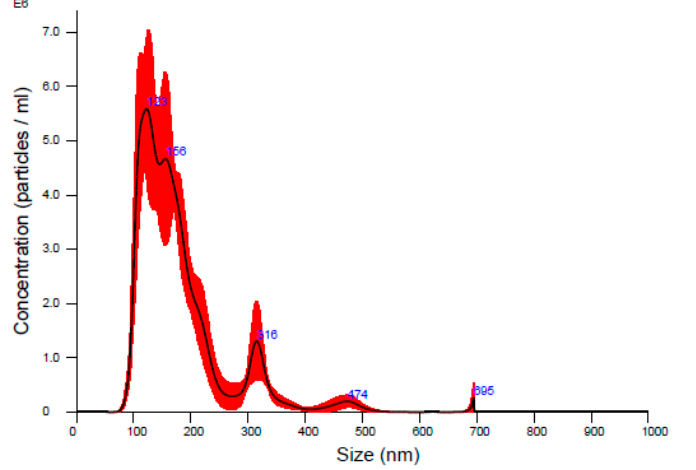
Figure 6. Size distribution from NTA measurements of an 80-fold diluted EV stock solution. The mean and mode diameter are 179 nm and 123 nm, respectively. The concentration is 6.0 × 10 8 particles/mL.